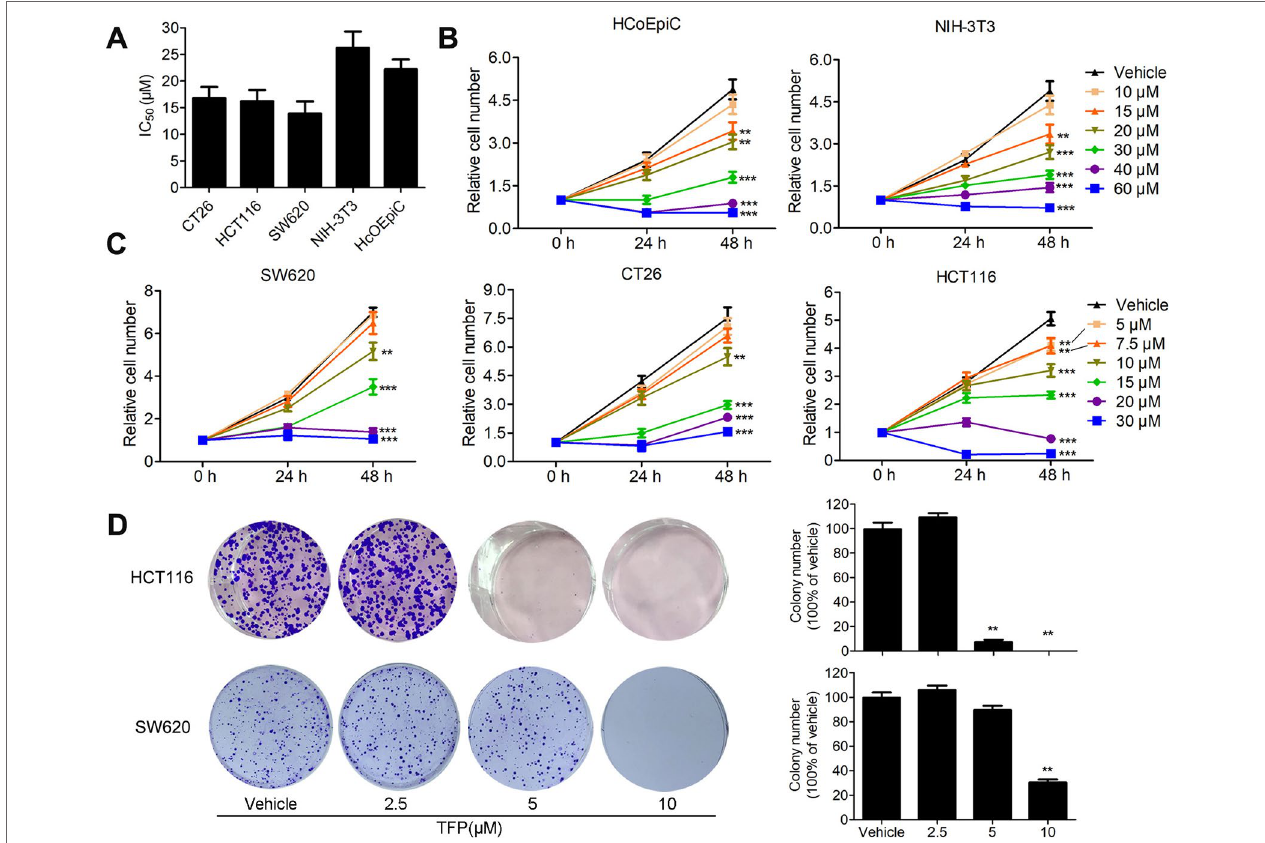
FIGURE 1 | The inhibitory effects of TFP on the viabilities of CRC cells and non-tumorigenetic cells. (A) Inhibitory effects of TFP on three CRC cell lines and two non- tumorigenetic cell lines after 48 h of treatment (IC 50 values, µM). (B and C) Cell proliferation curves of two non-tumorigenetic cell lines (B) and three CRC cell lines (C) after treatment with TFP at a range of doses for 48 h. Cell viabilities at each time point were measured by MTT assay and normalized to that at 0 h. (D) Effects of TFP on colony formation in CRC cell lines. Quantification is shown to the right of each cell line. **P < 0.01, ***P <